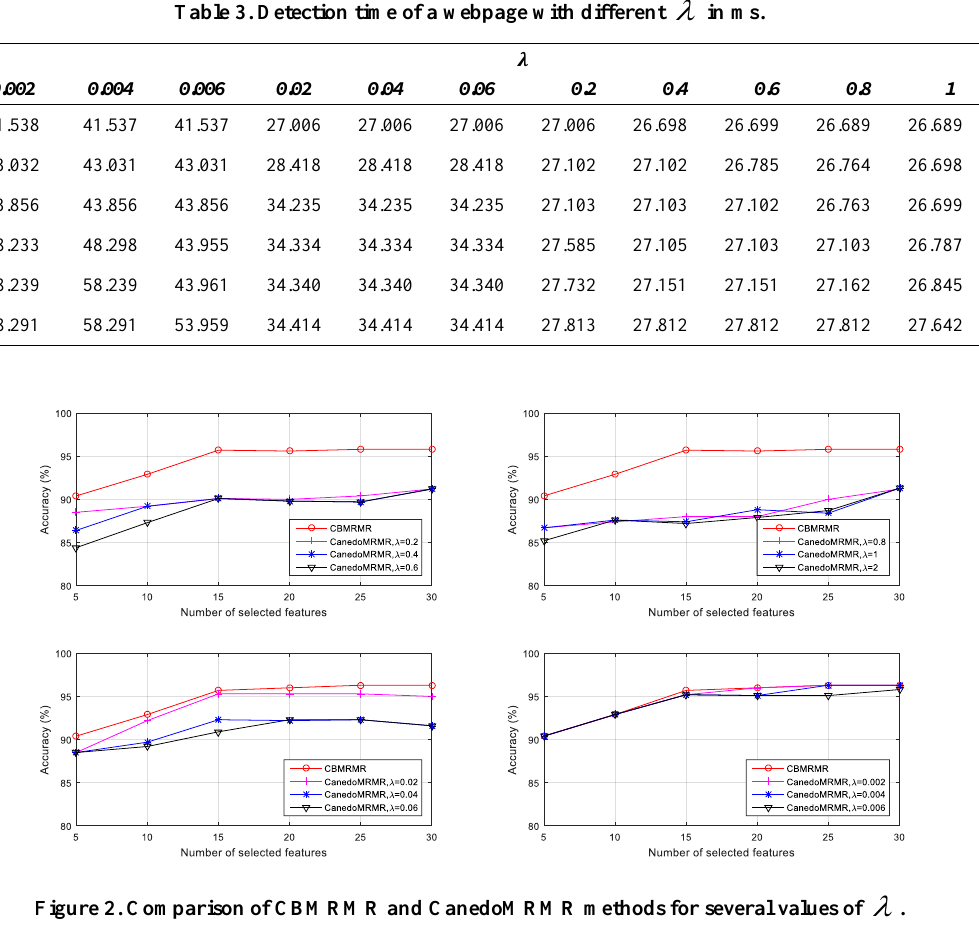
Figure 2. Comparison of CBMRMR and CanedoMRMR methods for several values of  .